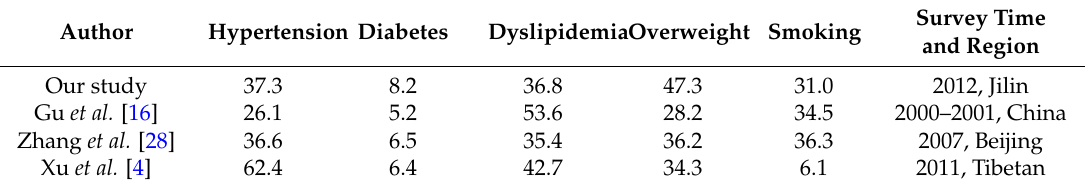
Table 6. The prevalence of CVD risk factors in previous studies